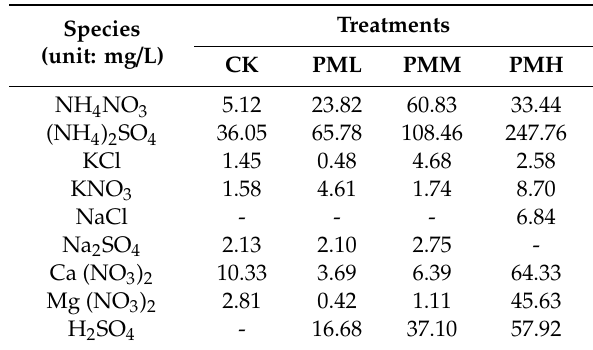
Abbreviations: WSII–PM 2.5 denotes water-soluble inorganic ions in PM 2.5 . CK (control); PML (low concentration